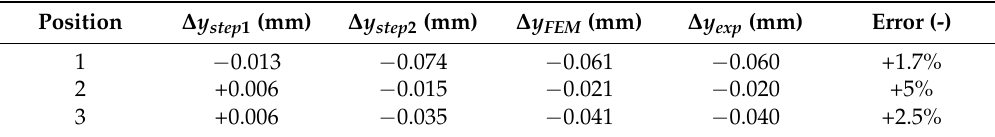
Figure 12. ( a ) FE displacements at first step (bolt preload); ( b ) displacements at second step (bolt preload plus external force). Table 3. FE displacements of the modified model at the end of the two steps, Δ y FEM and errors with respect to the experimental data.